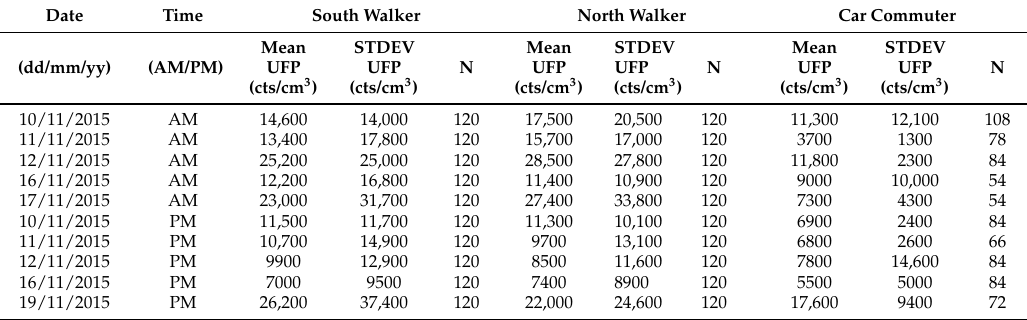
Table 1. Descriptive statistics of ultrafine particle concentrations. N is the number of 10 s observations, UFP is the ultrafine particle count and STDEV is the standard